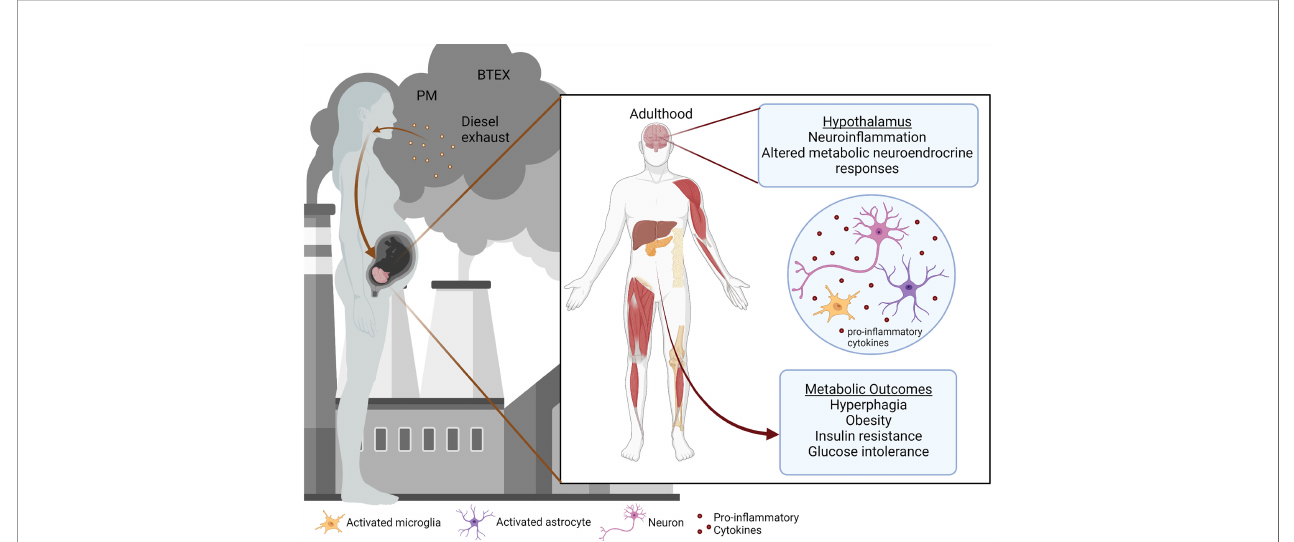
FIGURE 1 | Prenatal air pollution exposure induces hypothalamic and metabolic